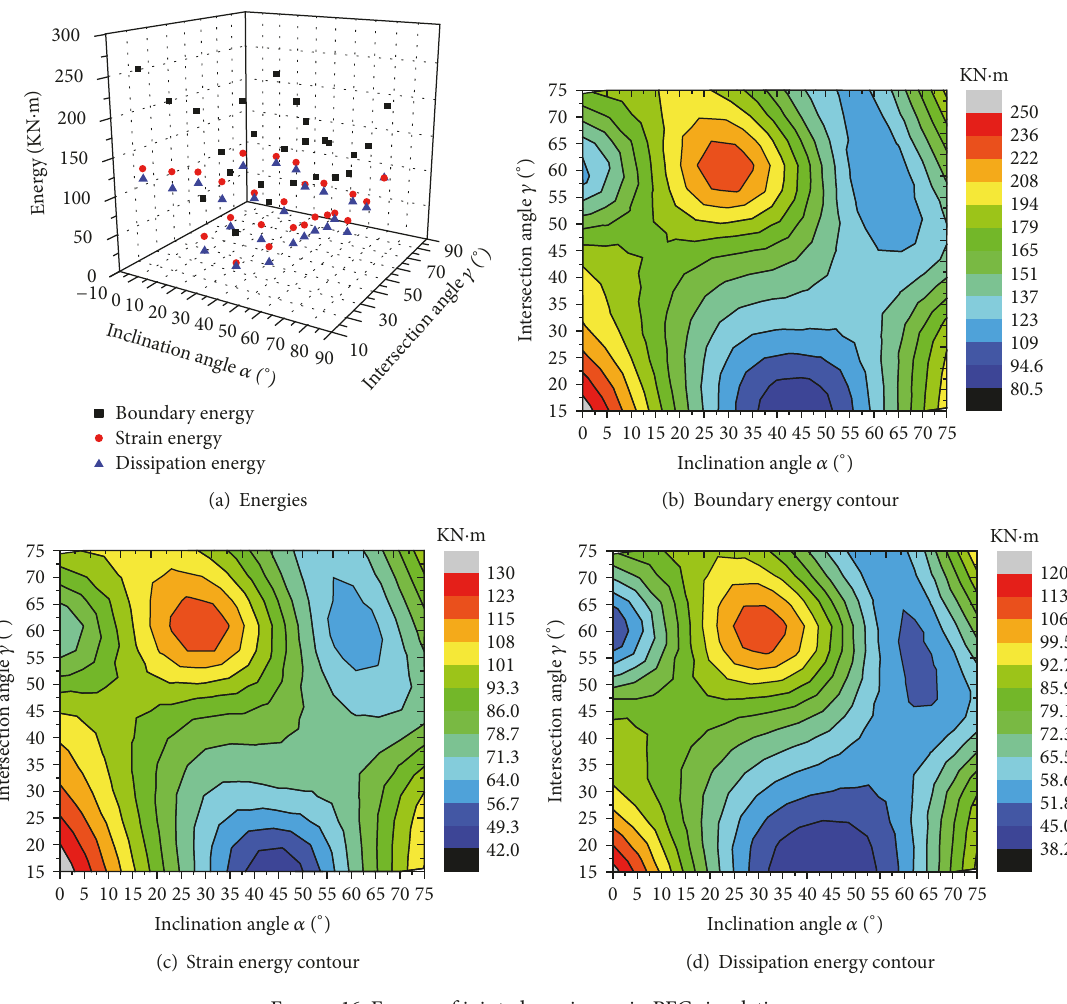
Figure 16: Energy of jointed specimens in PFC simulation.